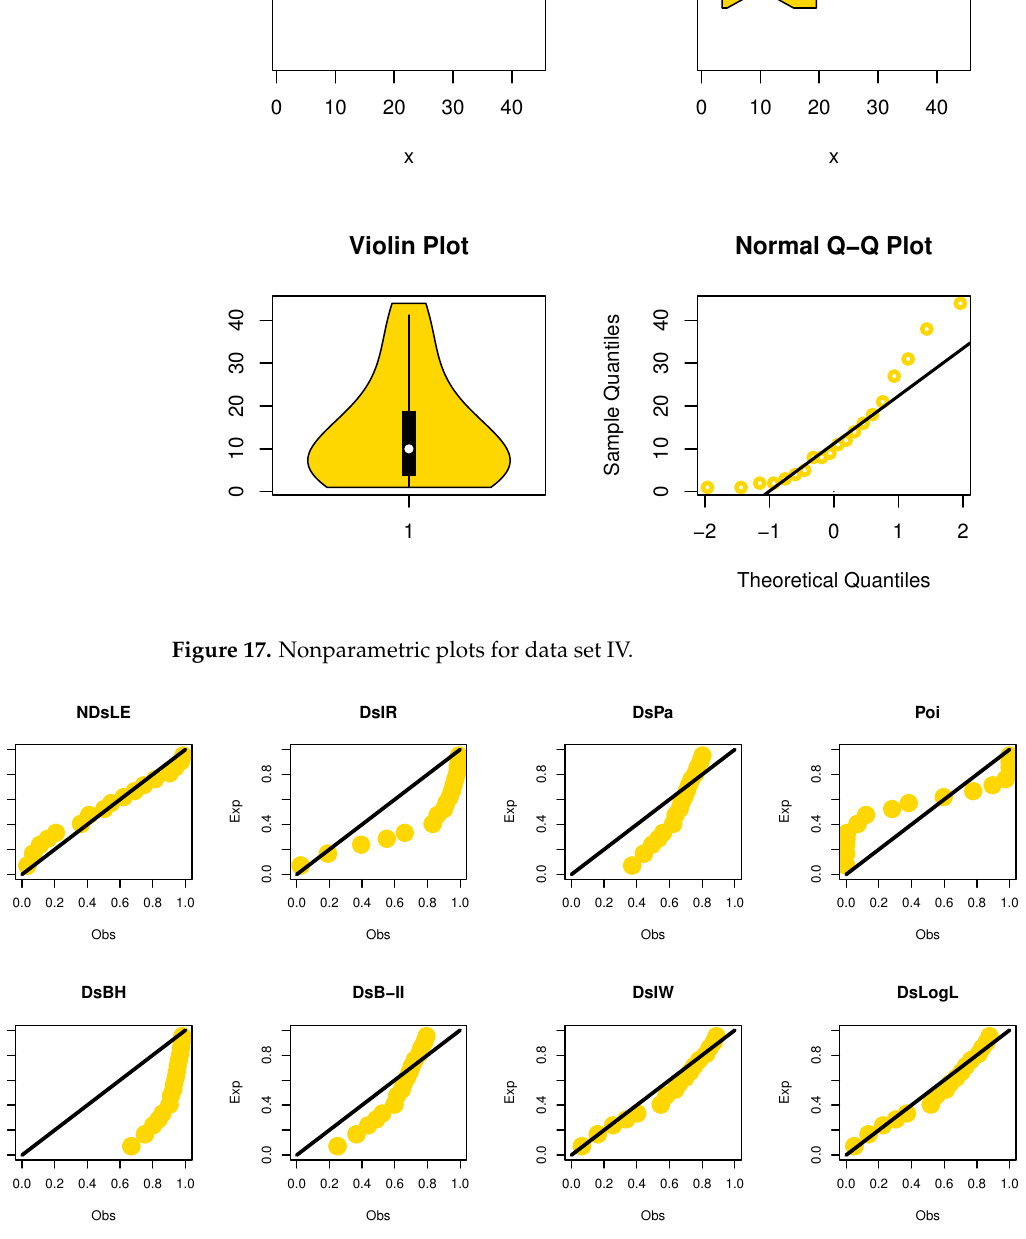
Figure 18. The empirical PPs plots for data set